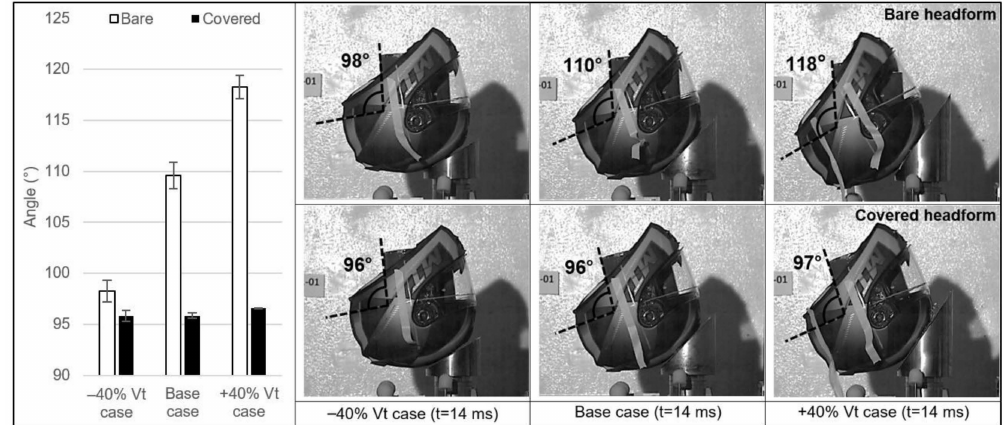
Figure 2. Comparison of the relative motion of the bare and covered headform inside the helmet at 14 ms of the front impact for each tangential